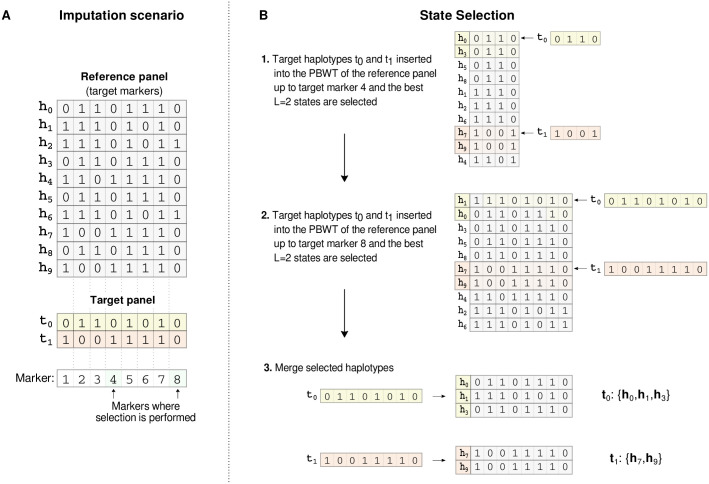
IMPUTE5 copying state selection.Small example to illustrate IMPUTE5 copying state selection. (A) A reference panel of haplotypes H = {h0, …, h9} is restricted to the set of target markers and is shown together with a target panel of two haplotypes T = {t0, t1}. The copying state selection is only performed at a subsetof target markers. In this example, these are the 4th and 8th markers, and are shaded green. (B) The target haplotypes are inserted into the PBWT, using the rank operations (FM-index). In (B1) target haplotypes {t0, t1} are searched in the positional prefix array of the reference panel up to marker 4 and L = 2 reference haplotypes are selected for each target haplotype. In (B2) t0 and t1 are searched in the positional prefix array of the reference panel up to marker 8 and again L reference haplotypes are selected. (B3) The selected haplotypes are then merged to form a list of copying states for each target haploype. The resulting lists may not necessarily have the same length. These states will be used in the HMM to perform imputation.